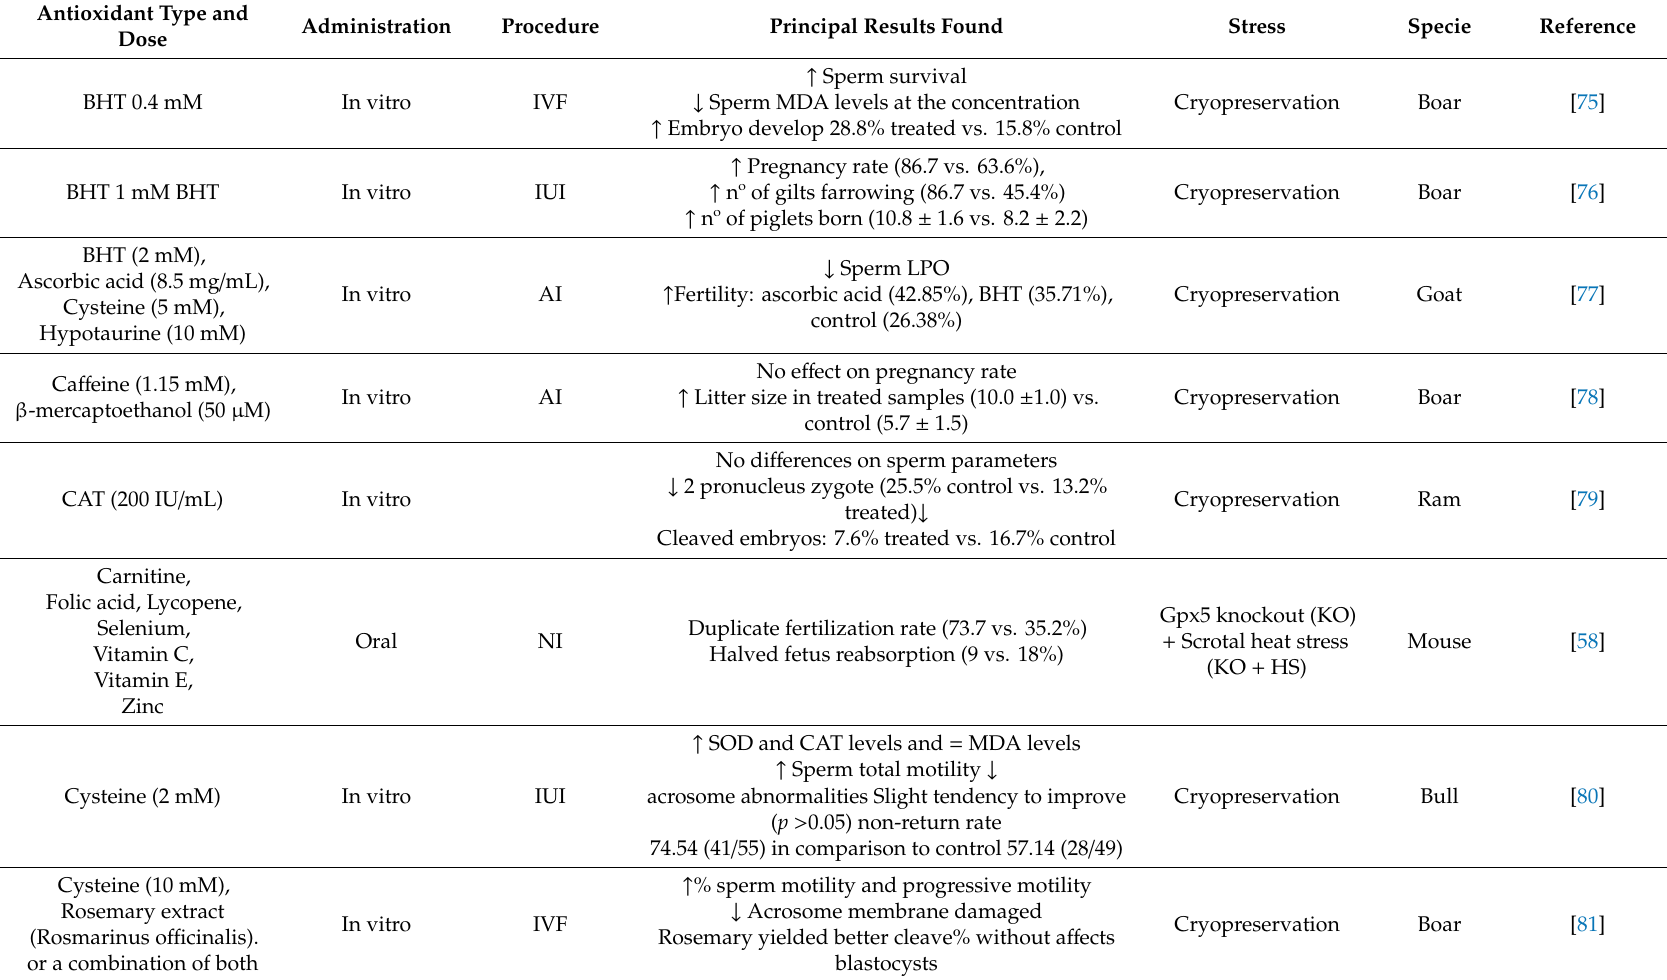
Table 2. Antioxidants used as additives in di ff erent ART and their reproduction